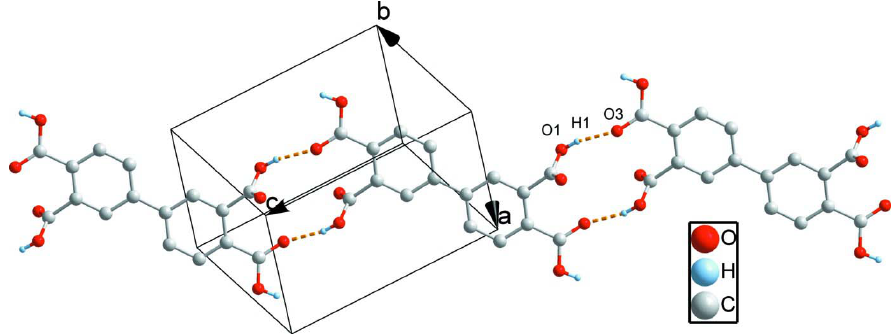
Figure 2 The one dimensional hydrogen bonded chain showing hydrogen bonds between the carboxyl units. Other H atoms have been omitted for